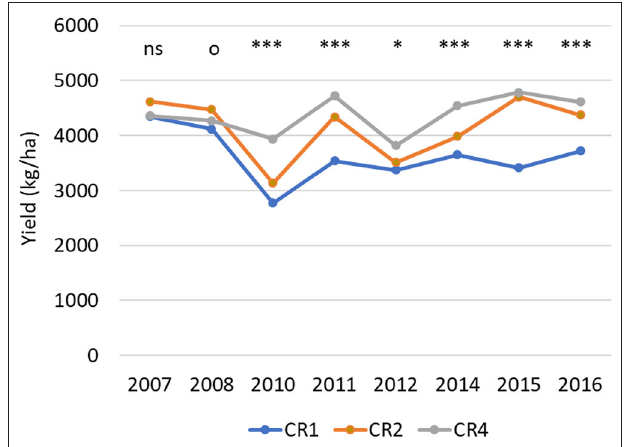
FIGURE 1 | The average spring wheat yield (kg/ha) in different years and crop rotations. CR1, wheat monoculture; CR2, wheat every 2nd year; CR4, wheat every 4th year. Statistically significant differences between yields: ns = not significant, o p < 0.10, * p < 0.05, *** p < 0.001.